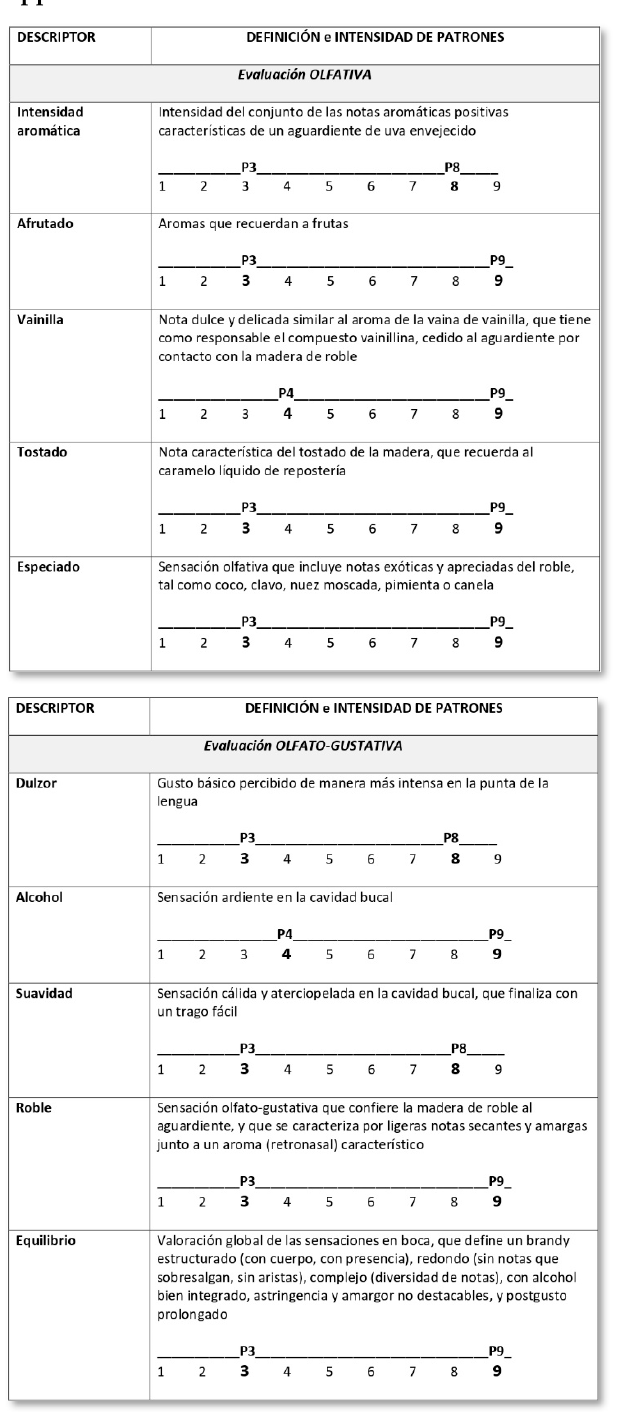
Figure A1. Tasting sheet used during the training of the judges, showing the score on the 9-point scale of the low- and high-intensity patterns for each descriptor.